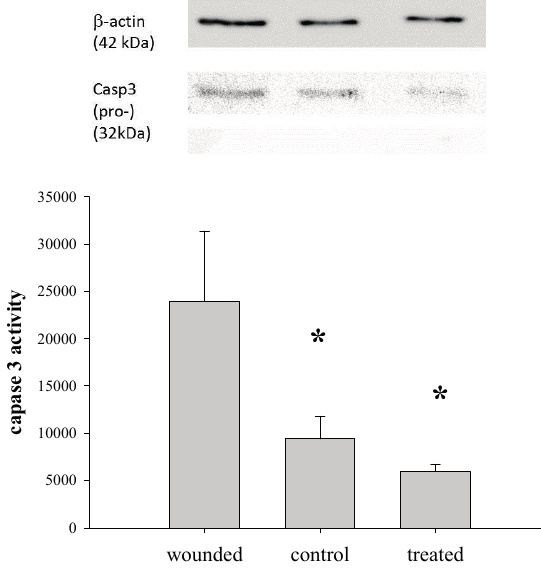
Figure 8. Caspase 3 activity of CAP3 pRFP-C-RS/PNT delivery in cornea